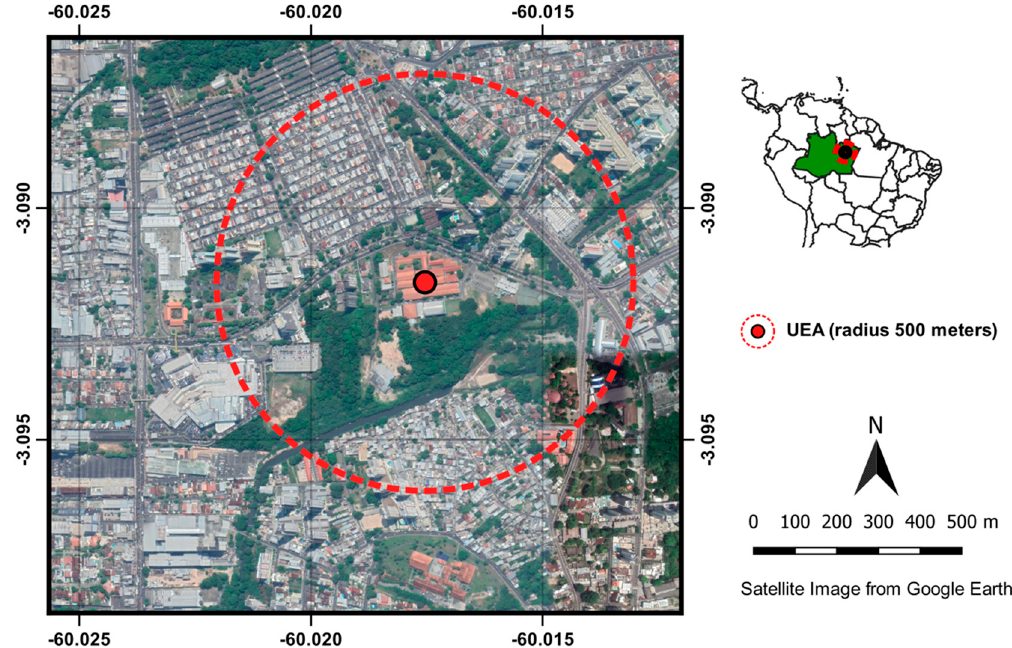
Figure 1. Representative image of the study area in the city of Manaus, Brazil, in central Amazon. The urban region is crossed by rivers and interspersed with forests. Nighttime flights to collect vertical profiles took place on the campus of the Amazonas State University (marked as a red disc and labeled “UEA”) in the middle of the city. The green region in the inset shows the state of Amazonas, Brazil, in South America.